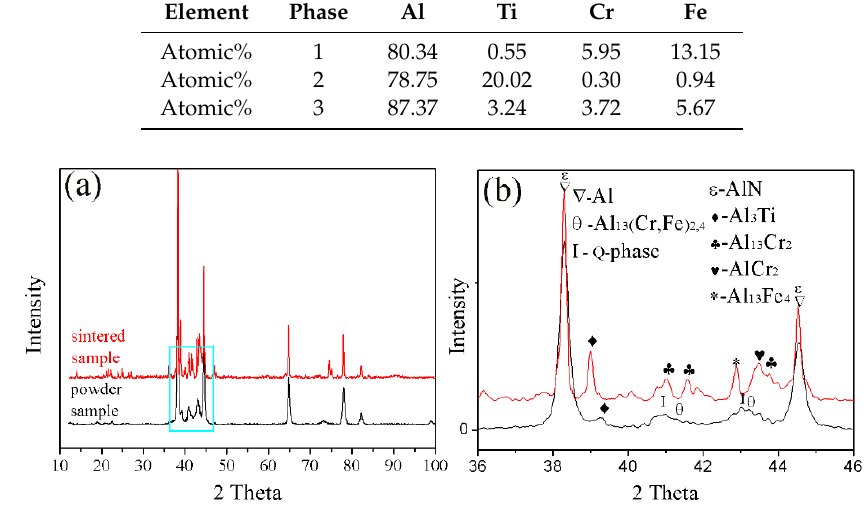
Figure 4. The SEM (scanning electron microscope)/BSE microstructure of the transverse section of atomized powder ( a,b ); FESEM (field emission scan electron microscope)/BSE micrographs of the fine powder particle ( c ); bright field TEM (transmission electron microscope)/BF micrographs of the fine powder particles ( d ). Table 3. The energy dispersive spectroscopy (EDS) of the three phases of the arrow in the microstructures of the particles.